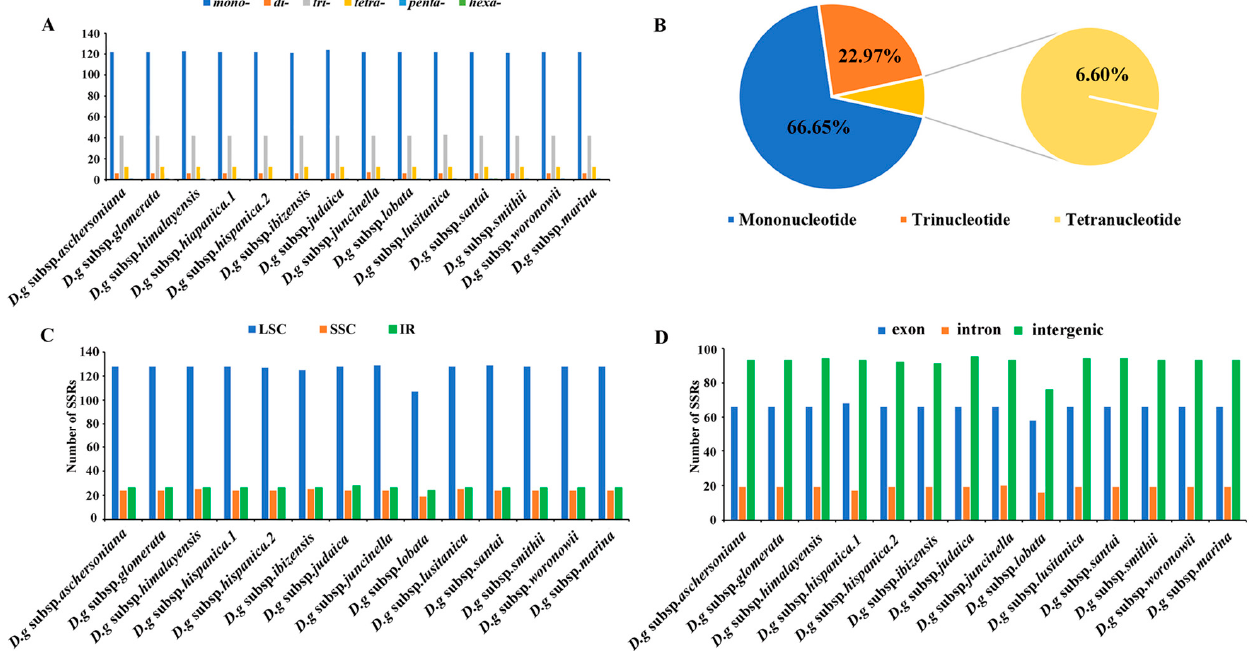
Figure 4. Analysis of simple sequence repeats (SSRs) in the cp genomes of 14 D. glomerata subspecies. ( A ) Number of different SSR types detected in cp genomes of D. glomerata subspecies; ( B ) The proportion of mononucleotide, trinucleotide and tetranucleotide SSRs; ( C ) Number of SSRs in LSC, SSC and IR regions; ( D ) Number of SSRs in exon, intron, and intergenic regions.